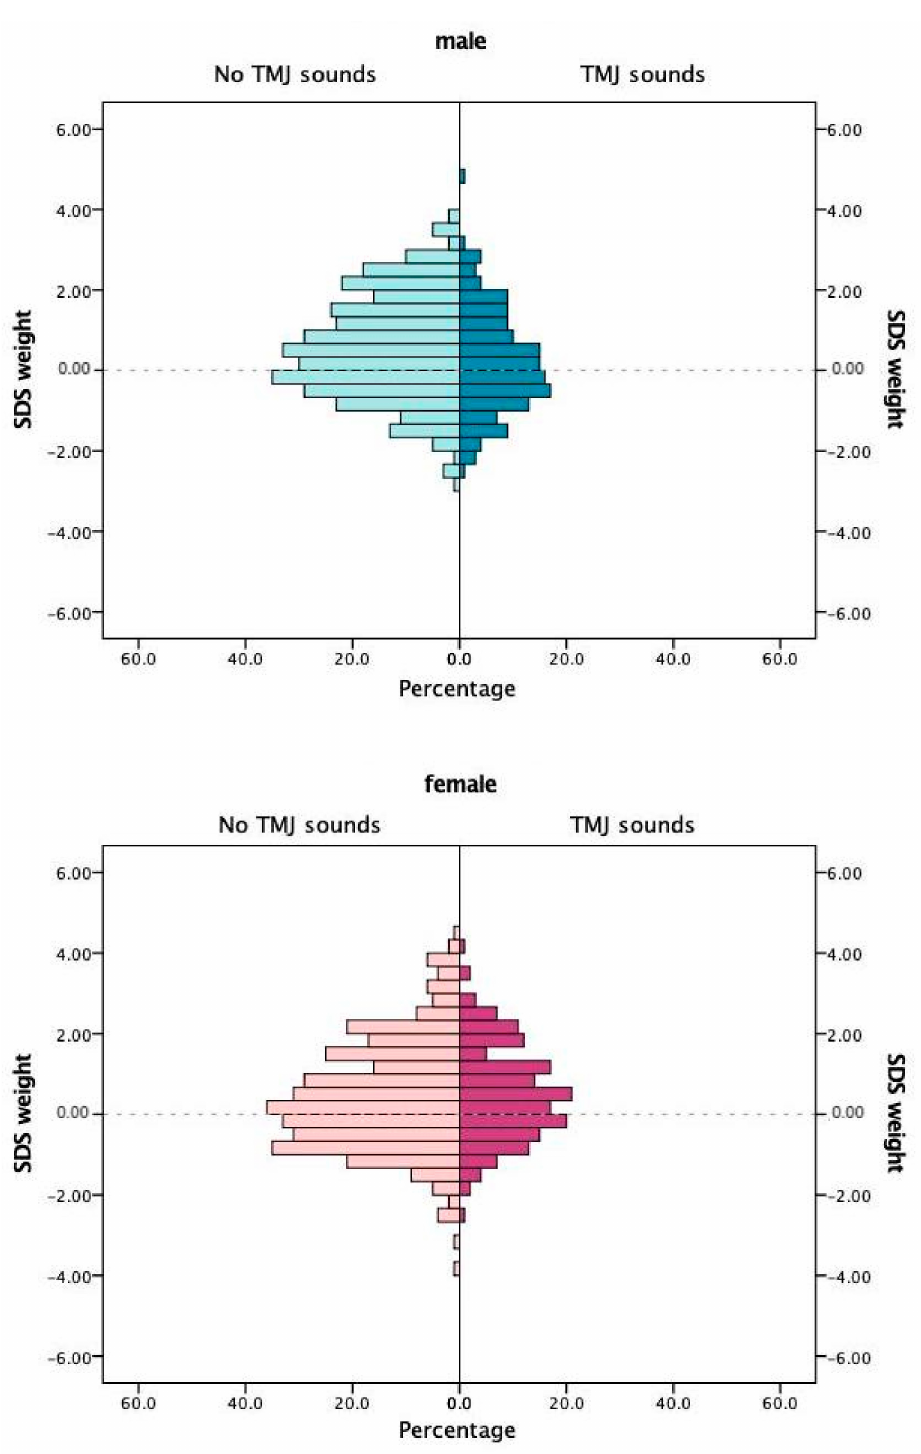
Figure 2. Standard deviation scores (SDS) of body weight in relation to temporomandibular joint